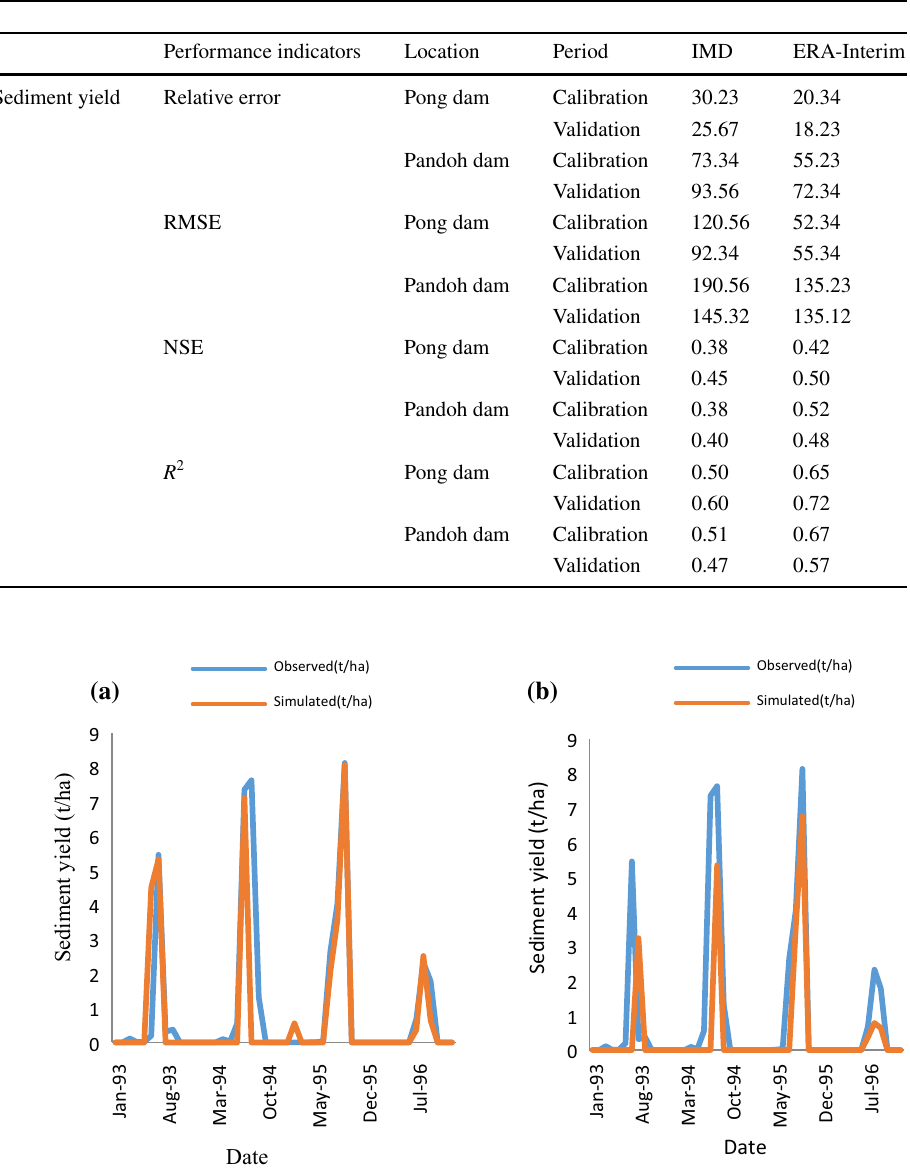
Performance indicators